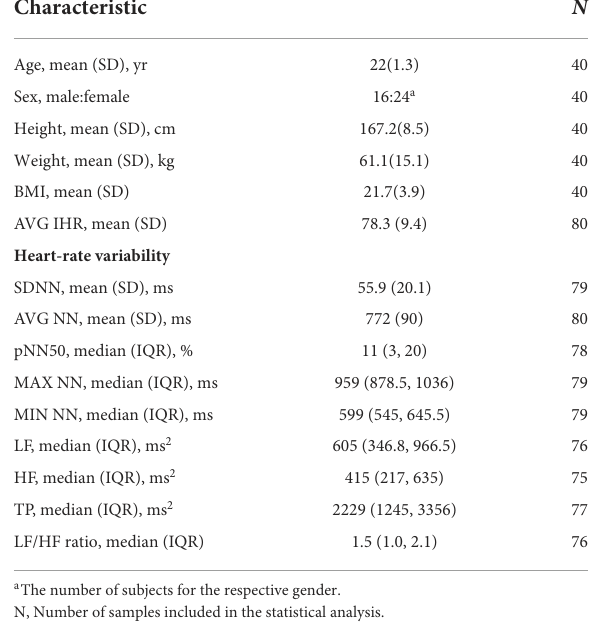
TABLE 1 Baseline characteristics of the subjects.